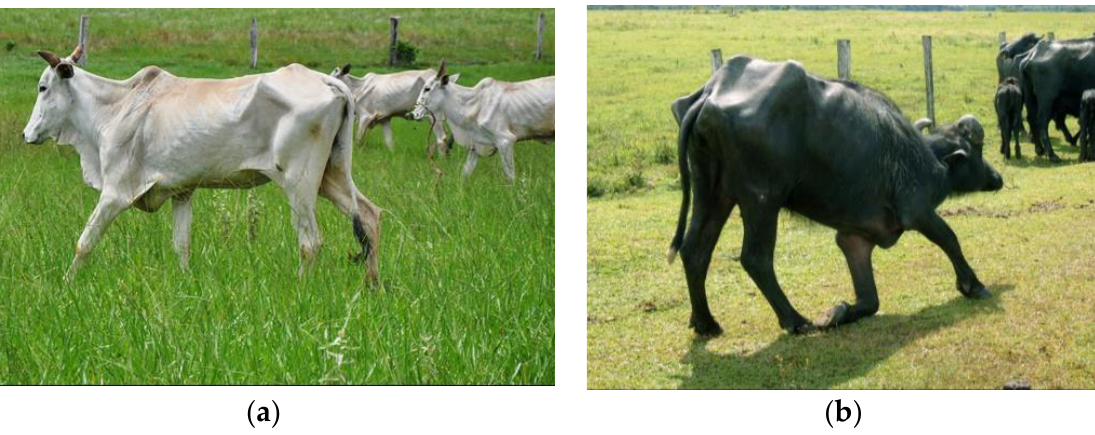
Figure 6. ( a ) Very lean Nellore cows (approximately 30 days of calving) with distinct difficulty in